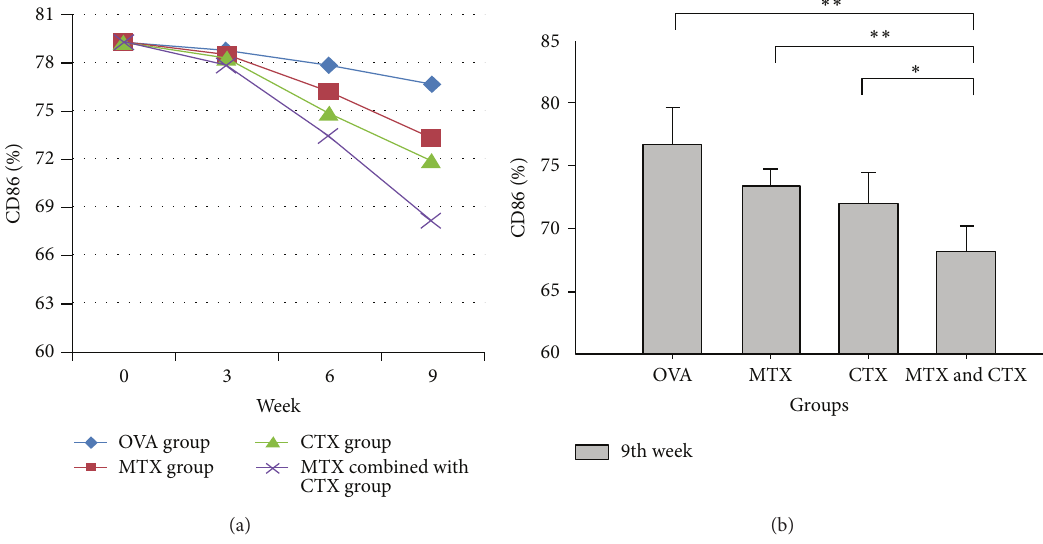
Figure 3: (a) Dynamic changes of CD86 expression in each group. (b) Comparison of CD86 expression in each group on 9th week. Data represented one of at least three independent experiments with 5 mice per group ( ∗ 𝑃 < 0.05 , ∗∗ 𝑃 < 0.01 ).